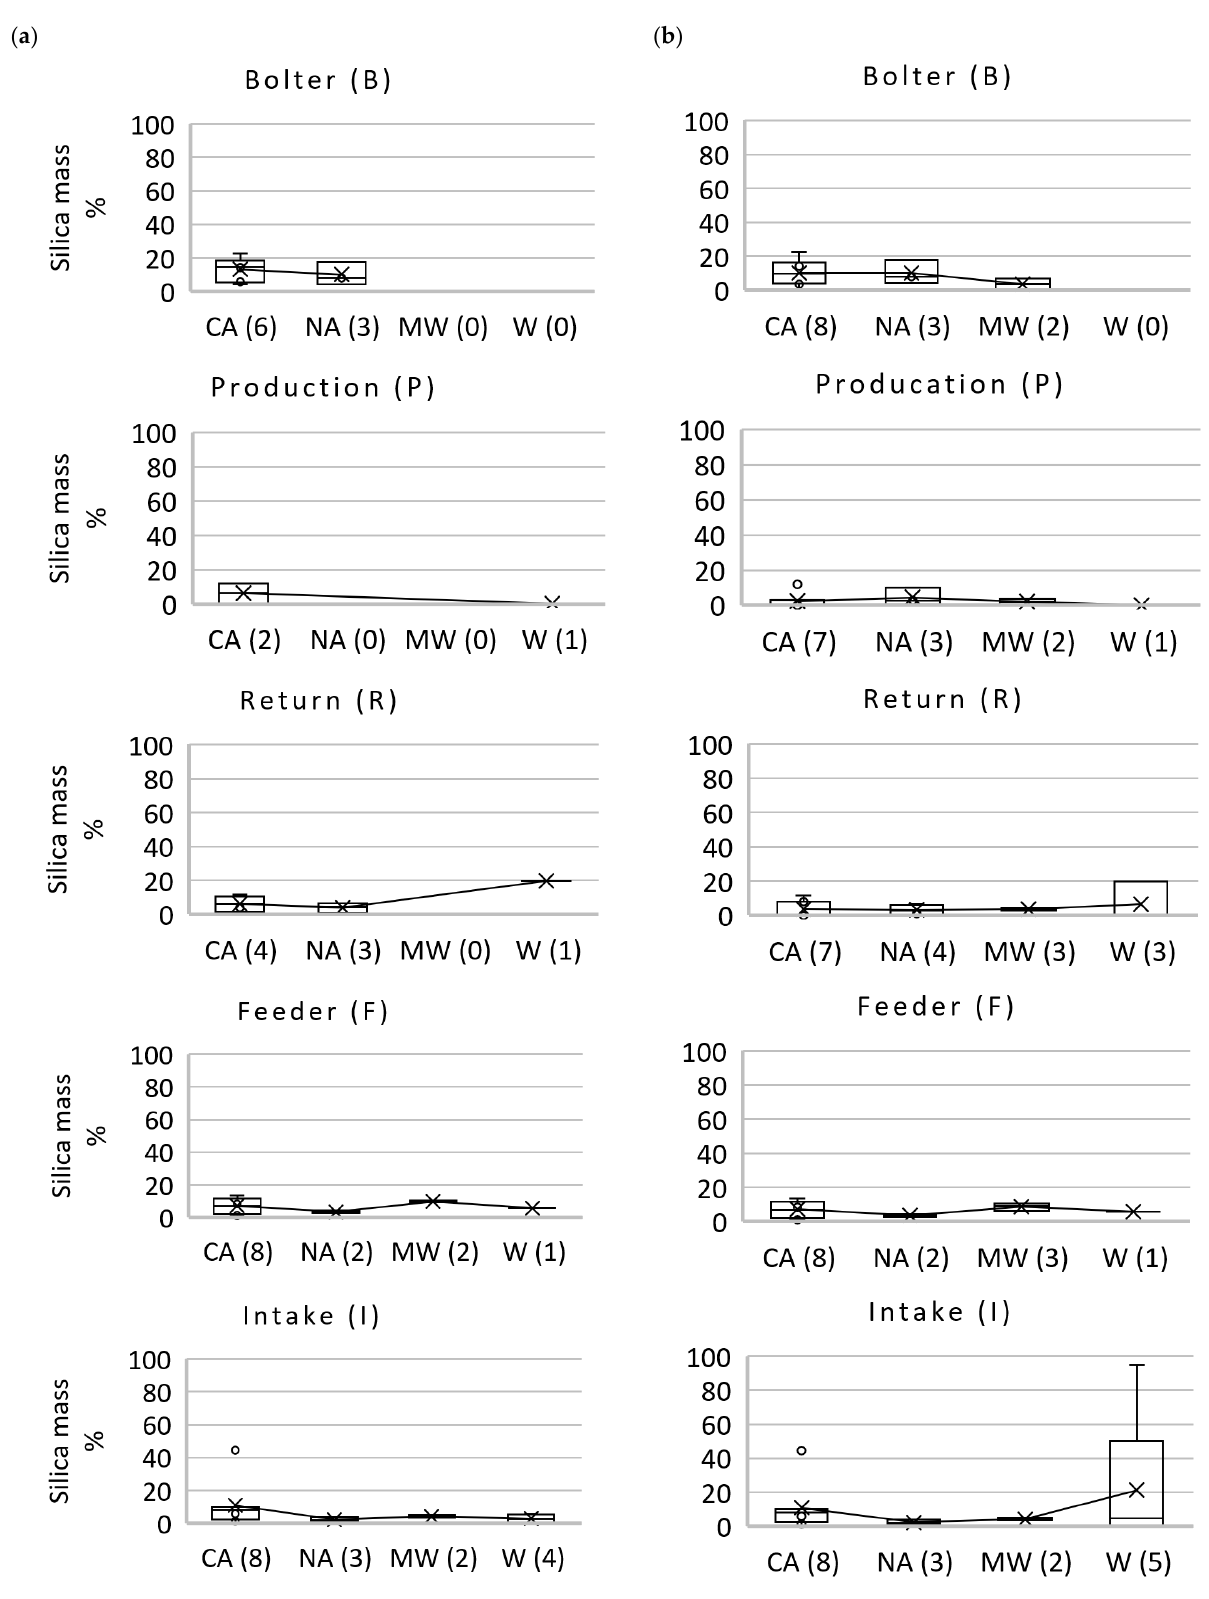
Figure 4. Distribution of silica mass% estimated from SEM-EDX for the RCMD samples, with plots shown by mine region for each sampling location. In ( a ) high-PLD samples are excluded, in ( b ) all samples are included regardless of